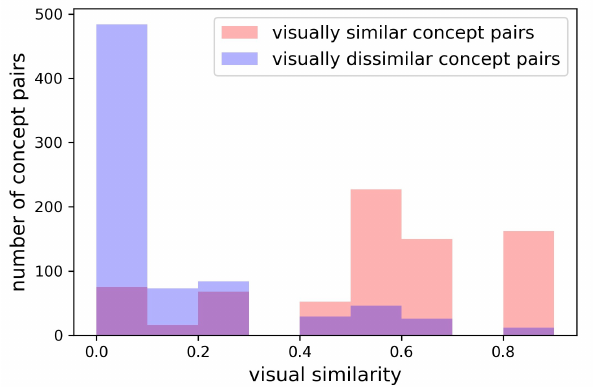
Figure 10. Distributions of visual similarities for each type of concept